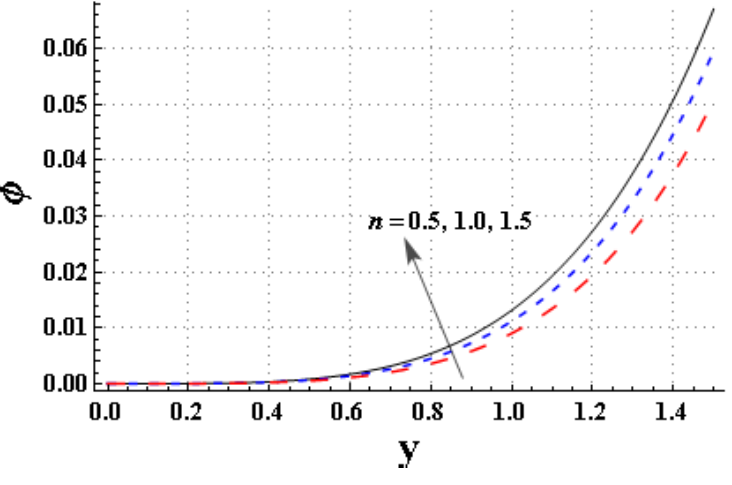
Figure 17. Effect of the power law index,